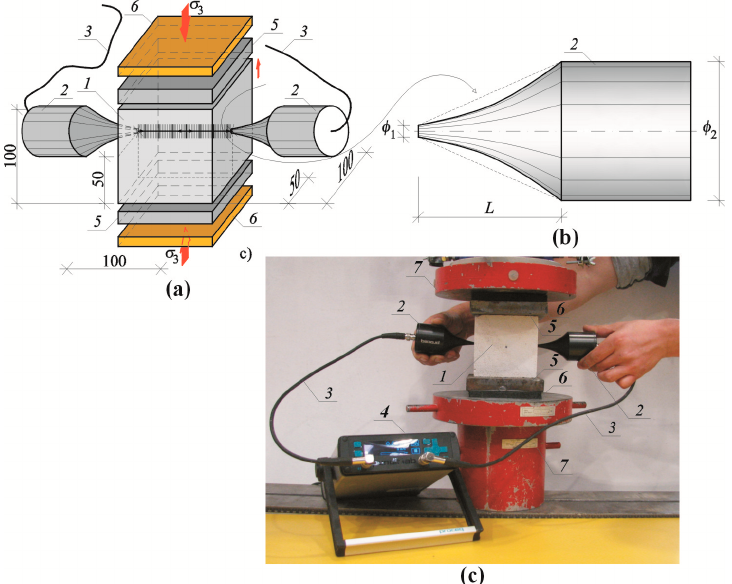
Figure 3. A test stand for measuring ultrasonic wave velocity in compressed specimens: ( a ) specimen geometry and elements of the stand, ( b ) geometry of exponential transducer, ( c ) a test stand; 1 —tested AAC specimen 100 × 100 × 100 mm, 2 —exponential transducers, 3 —cables connecting transducers with recording equipment, 4 —recording equipment, 5 —steel sheet, 15 mm thick, 6 —vibration isolation, 7 —heads of testing machine. Table 2. Test results for ultrasound velocity in AAC at various compressive stresses.